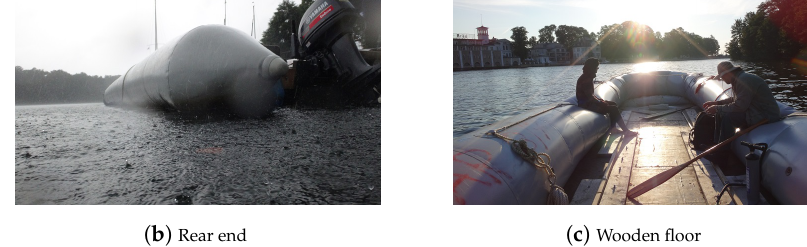
Figure 1. The vessel on its way to the test-bed lake.